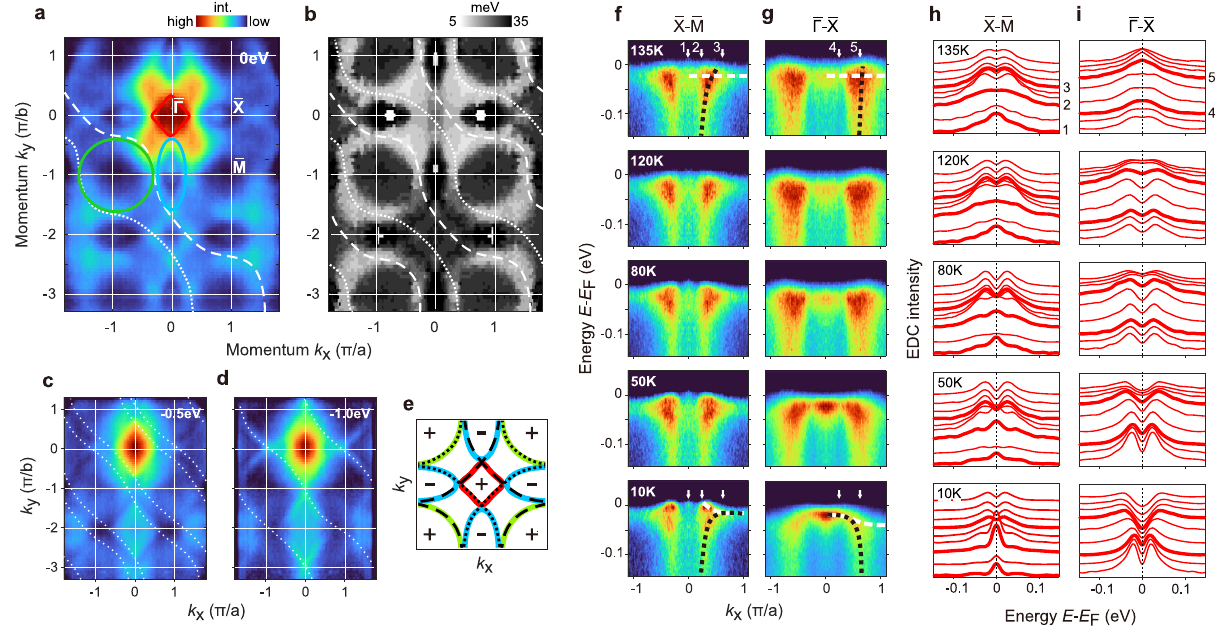
Fig. 3 | Band structure measurements on USbTe. a Fermi level ARPES intensity distribution, measured at T =20K with h ν =98eV photons. Guides to the eye are shown for diamond, circle, and oval Fermi contours present at high temperatures ( T >80K). b Gap map,showing the binding energy distributionoftheclosestband feature to the Fermi level at T =20K (see Methods). c , d A light quasi-1D band is traced on constant energy ARPES maps. e The high-temperature Fermi surface of